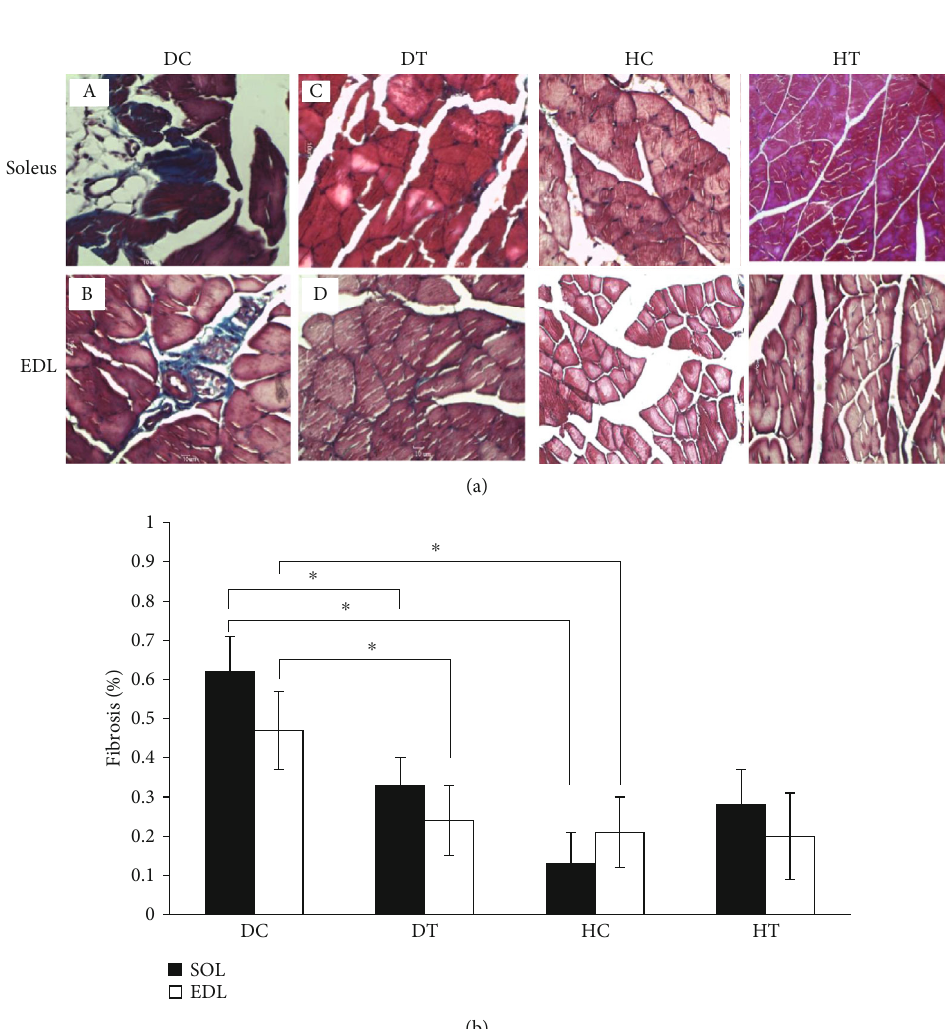
Figure 2: Muscle fi brosis in soleus and EDL muscles in di ff erent groups. Masson ’ s trichrome staining was used to determine the amount of collagen in the muscle tissue. (a) (A) The soleus muscle and (B) the EDL muscle of the DC group. (C) The soleus muscle and (D) the EDL muscle of the DT group. Muscle fi brosis is in blue. (b) Among the soleus muscles, the highest level of collagen was in the soleus muscle of the DC group (A) ( P ≤ 0 : 05 ). The highest level of collagen among EDL muscles was in the DC group (B) ( P ≤ 0 : 05 ). The exercise training signi fi cantly decreased the amount of tissue fi brosis in the DT group in both muscles (C and D) ( P ≤ 0 : 05 ). Scale bar on pictures is 10 μ